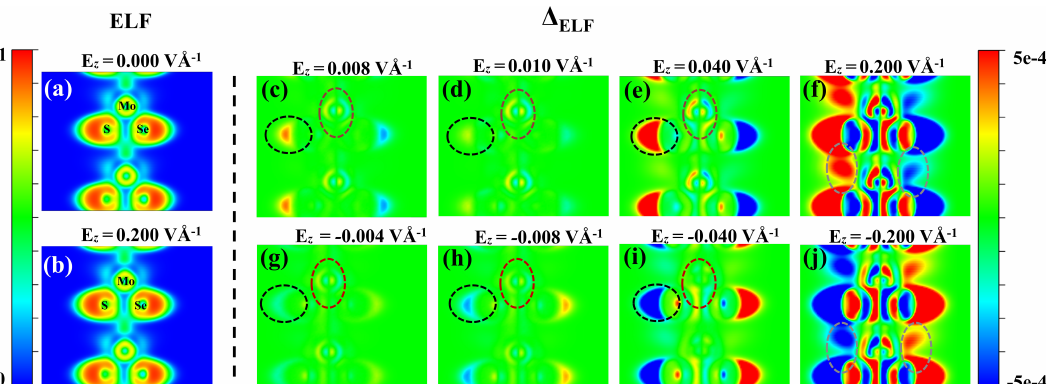
Fig. 5 The comparison of electron localization function (ELF) and the differential ELF ( Δ ELF ). Detailed ELF of a the pristine state and b under positive external electric fi eld of 0.2 VÅ − 1 . c – j The differential ELF ( Δ ELF ) under the typical positive (c-f: 0.008, 0.01, 0.04, 0.2 V Å − 1 ) and negative ( g – j : − 0.004, − 0.008, − 0.04, − 0.2 V Å − 1 ) external electric fi elds. ( Δ ELF = ELF( E z ) – ELF ( E z = 0)). The ( − 1 2 0) surface is chosen for all the con fi gurations and the isosurface is set as 10 − 5